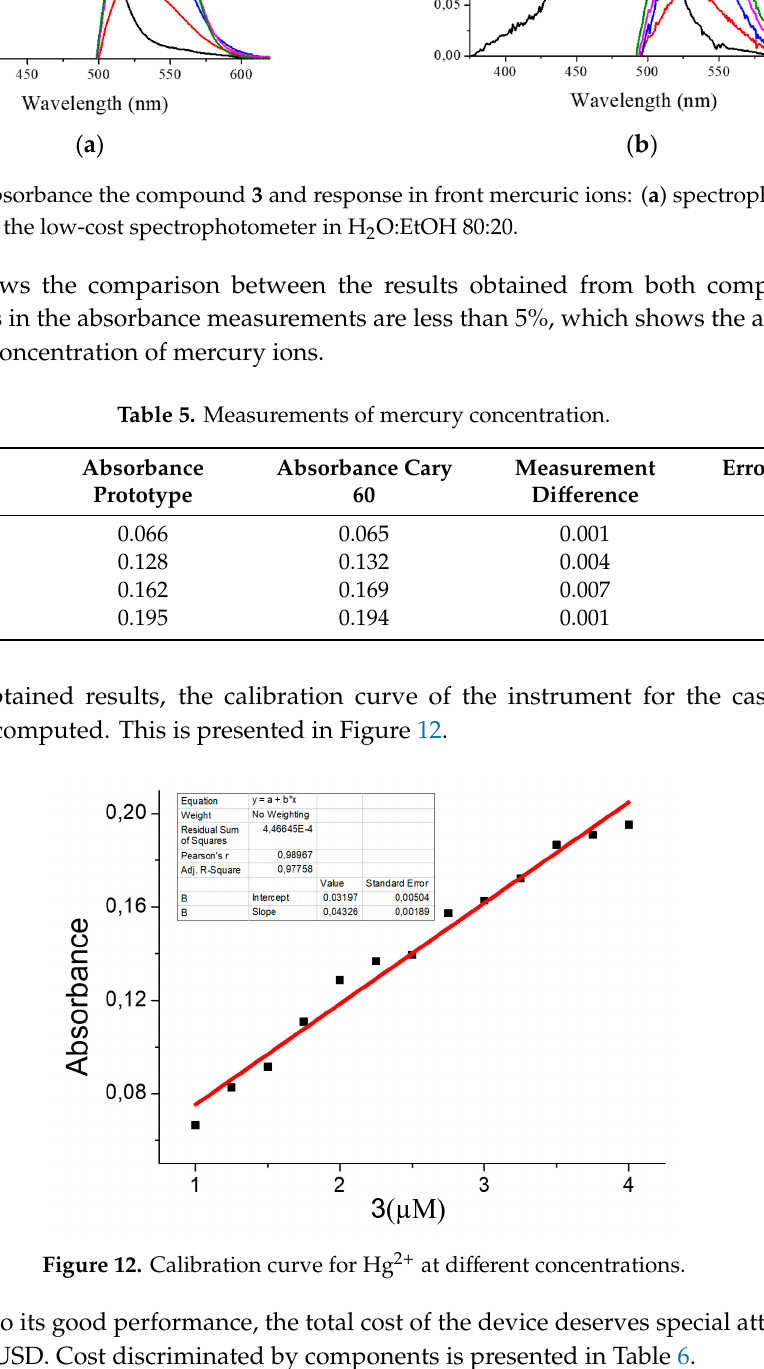
Figure 12. Calibration curve for Hg 2+ at different concentrations.